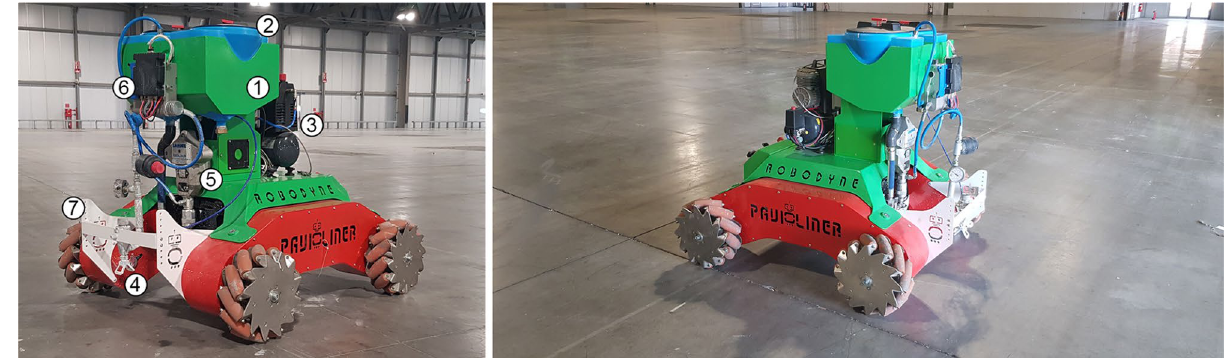
Figure 19. Omnibot equipped with a spraying unit, on the left, and the vehicle during the tests in the Fieramilano area in Rho, Italy, on the